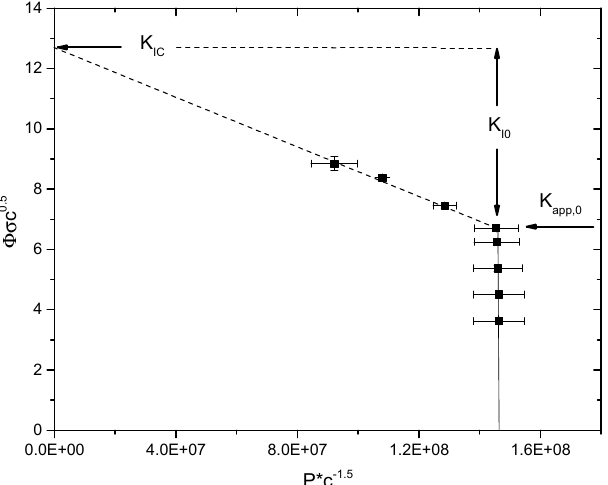
Figure 5. SIGB plot showing the determination of stress intensities K IC , K app,0 and K I0 of 2Y-TZP sintered at 1350 °C.